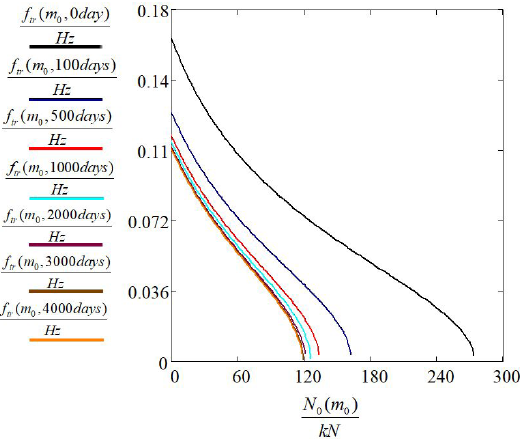
Figure 5. Results for Δ T = +15ºC.